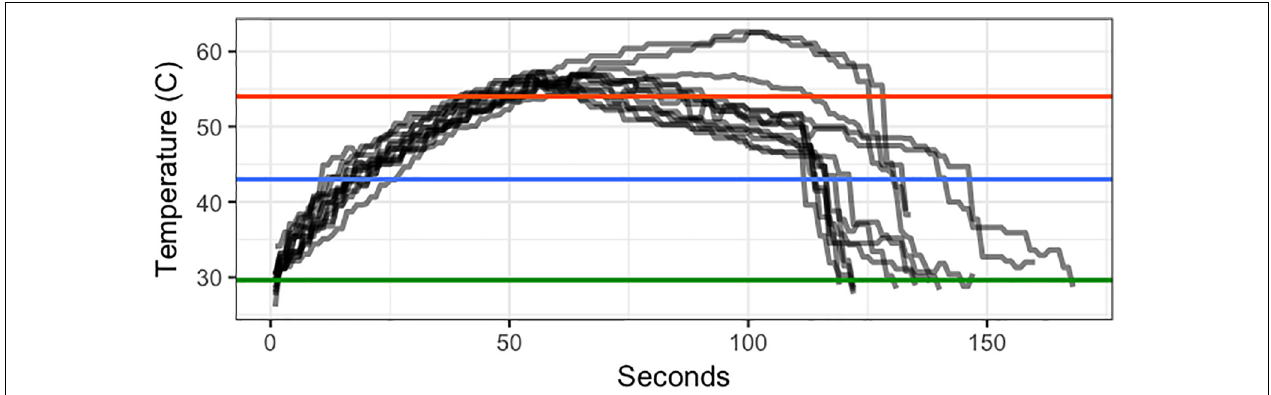
FIGURE 1 | Temperature ( ◦ C) of heat treatments over time (seconds after start of heating) in Trial 2. Green line shows the ambient temperature. Blue line shows the minimum threshold target temperature (43 ◦ C). Red line shows the maximum target temperature (54 ◦